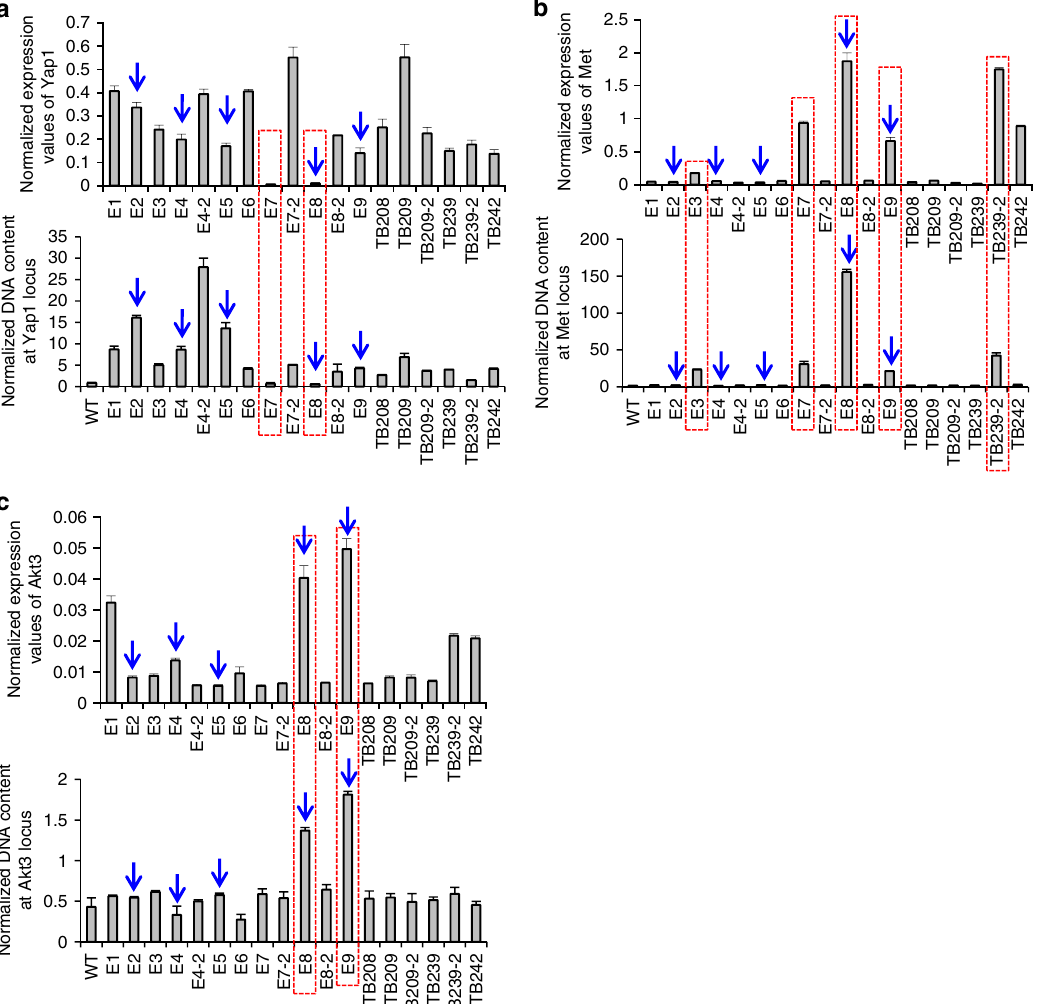
Figure 6 | PCR analyses confirming recurrent genomic lesions in Type 1 and 2 mammary tumours. ( a – c ) qRT-PCR (top, normalized to expression levels of Gapdh ) and genomic PCR (bottom, normalized to the Lsd1 gene body, which exhibits no amplification based on SNP analysis) analyses showing excellent correlation of Yap1 ( a ) and Met ( b ) overexpression with amplification of their corresponding genes in multiple tumours developed in the Ad-K8-Cre/Trp53 L/L and K8-CreER;Trp53 L/L (tamoxifen) models. In a , two tumours (E7, E8) with no Yap1 overexpression/amplification are highlighted in red. In b , five tumours (E3, E7, E8, E9 and TB239-2) with both Met overexpression and gene amplification are highlighted in red. The PCR analyses also show correlation of Akt3 overexpression with its gene amplification in tumours E8 and E9 (highlighted in red) ( c ). In a – c , five tumours analysed in Fig. 5a are indicated by arrows. Data represent mean ±